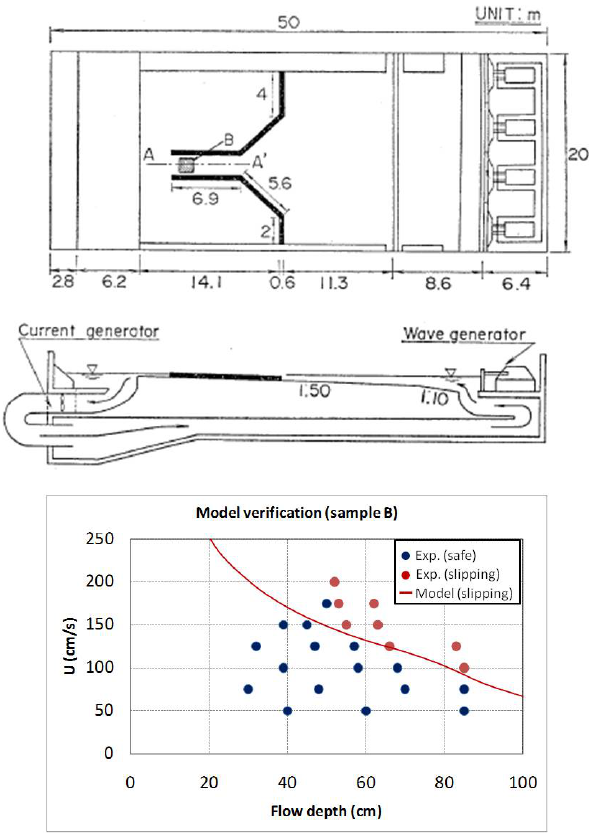
Fig. 12. Verification of the proposed model using data from a hy- draulic experiment, upper figure shows the schematic wave tank used in the experiment by Endoh and Takahashi (1995). Bottom figure is the verification result with present model. Solid line is the critical condition for the slipping fall type obtained from the